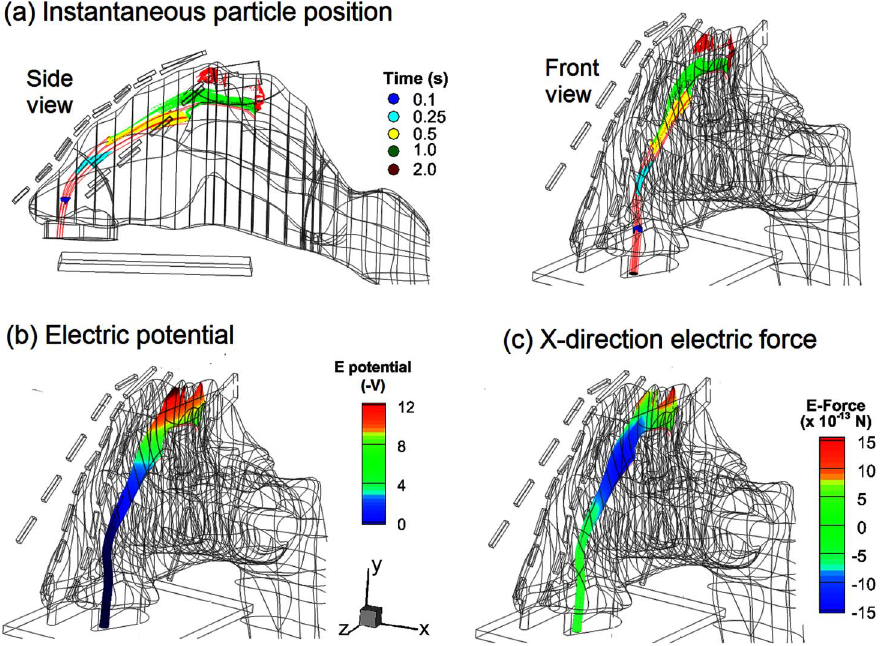
Figure 9. Snapshots of particle locations (a), electric potential (b) and electrophoretic force in x direction (c) in the left nasal passage for particles released at point B.